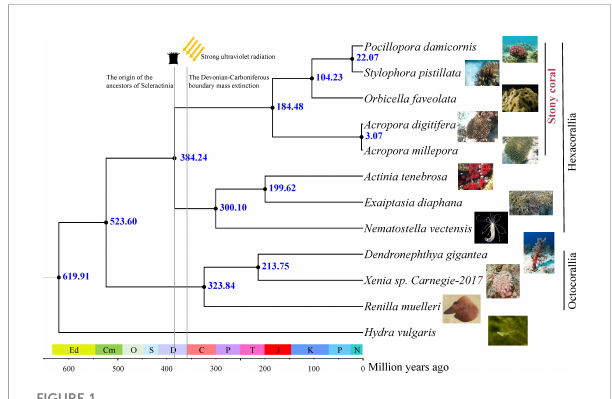
FIGURE 1 Phylogenetic tree and divergence times based on the fourfold degenerate sites of 1,463 one-to-one orthologous genes. The images of each species are from the